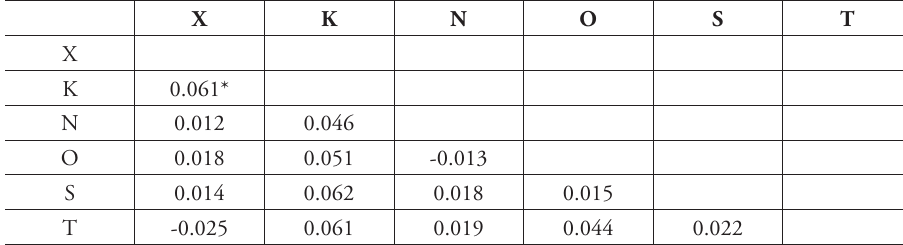
* significant at P < 0.05 by the permutation